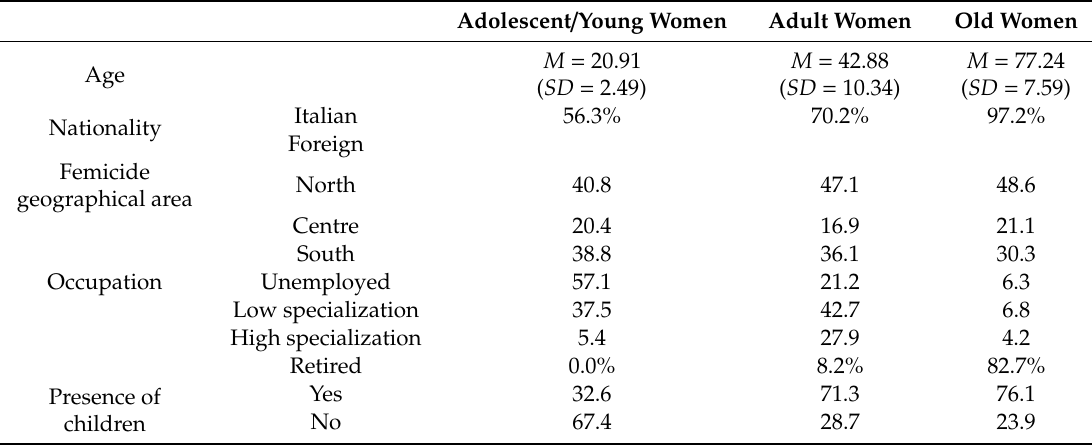
Table 1. Descriptive statistics for victims of femicide by age groups.